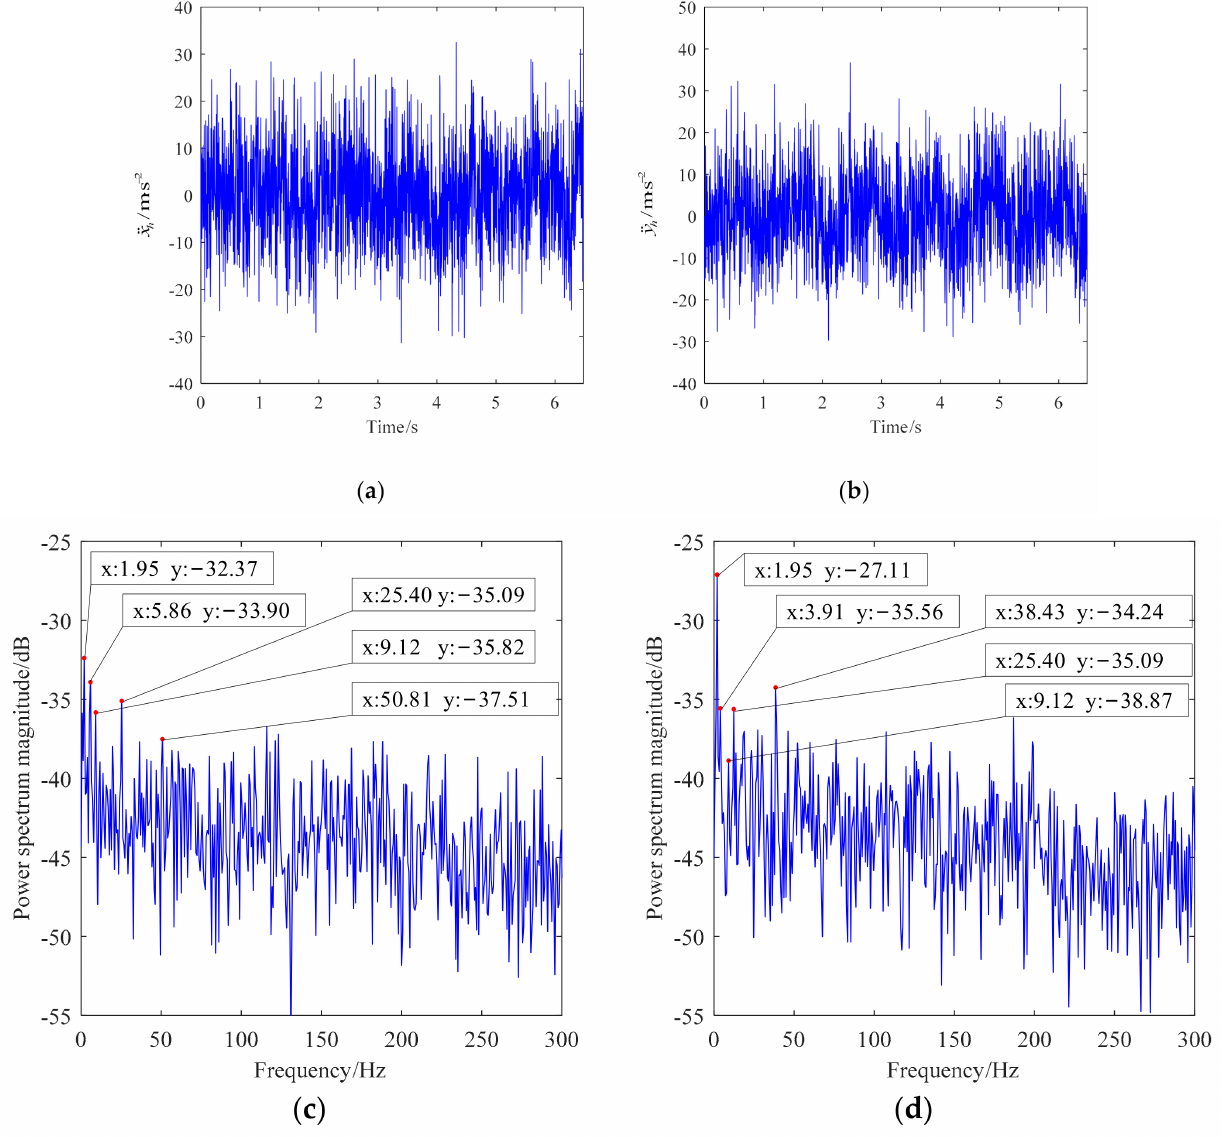
Figure 3. Acceleration characteristics of the cutting head when f p = 6. ( a ) time-domain characteristics of acceleration in the x h -direction, ( b ) time-domain characteristics of acceleration in the y h -direction, ( c ) power spectrum of acceleration in the x h -direction, ( d ) power spectrum of acceleration in the y h -direction. Figure 4 is the time-domain curve and spectrum of cutting head vibration acceleration in x and y directions when f p = 10. Due to the hard rock and the strong impact characteristics of rock breaking force, the maximum vibration acceleration exceeds 100 m/s 2 at a few time points. The vibration frequency is still concentrated in the low frequency, the main frequencies in the x-direction are 0.97 Hz, 1.93 Hz, 2.9 Hz, 9.35 Hz and 22.53 Hz respectively, the main frequencies in the y-direction are 0.97 Hz, 1.93 Hz, 2.58 Hz, 11.92 Hz and 24.17 Hz respectively, and their vibration frequencies are close to the frequency doubling of the spindle rotation